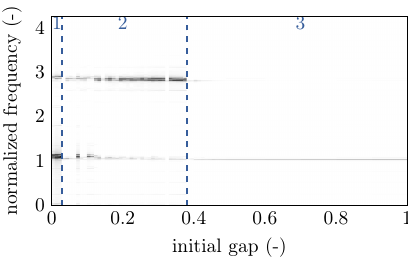
Figure 20. Evolution of the frequency response function of the blade displacement with the initial clearance for the HP compressor